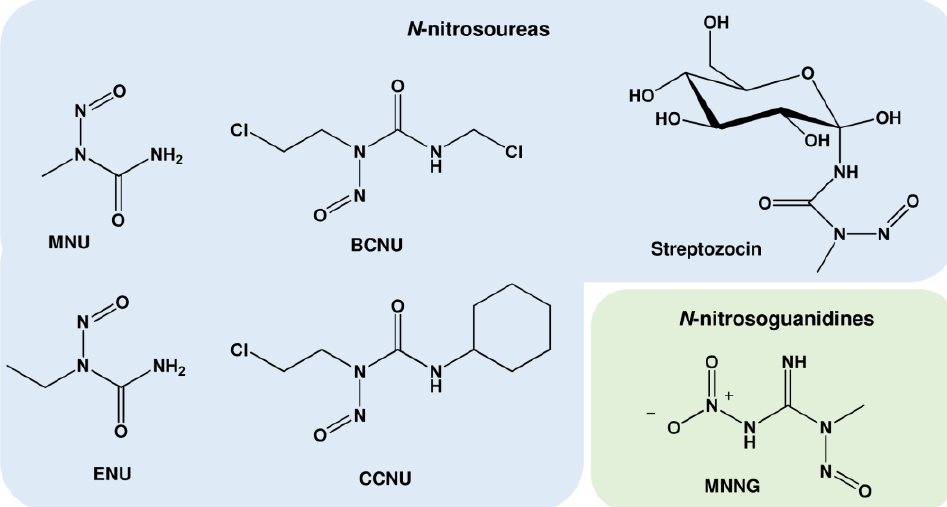
Figure 4. Chemical structure of important nitrosamides. MNU: N-methyl-N-nitrosourea; ENU: N-ethyl-N-nitrosourea; BCNU: 1,3-Bis(2-chloroethyl)-1-nitrosourea; CCNU: 1-(2-chloroethyl)-3-cyclohexyl-1-nitrosourea; MNNG: N-methyl-N ’ -nitro-N-nitrosoguanidine.